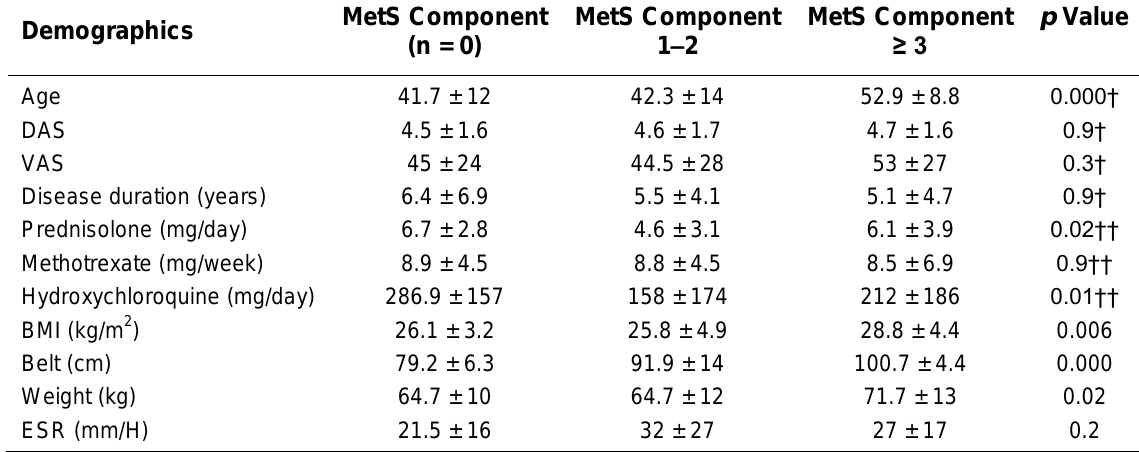
Correlation between Existence of Metabolic Components and Important Demographics of RA